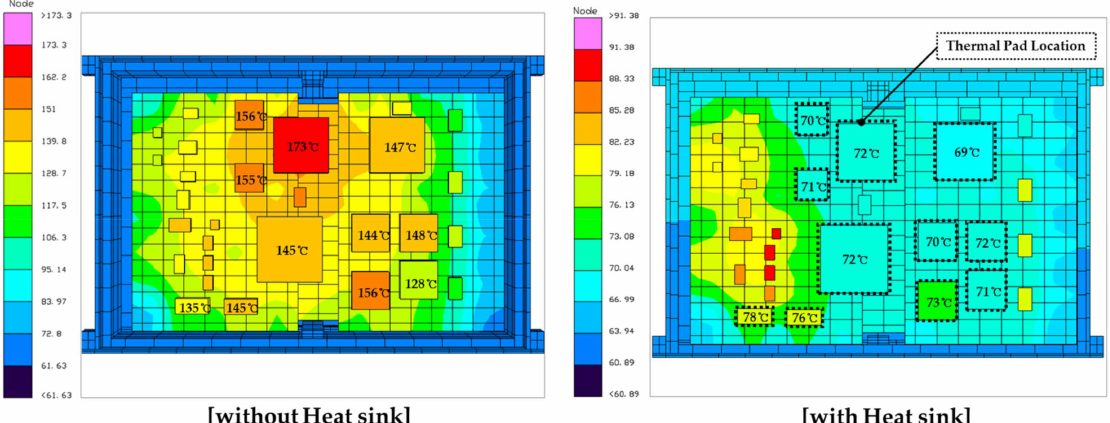
Figure 7. Temperature contours of DRX1(P) with and without heat